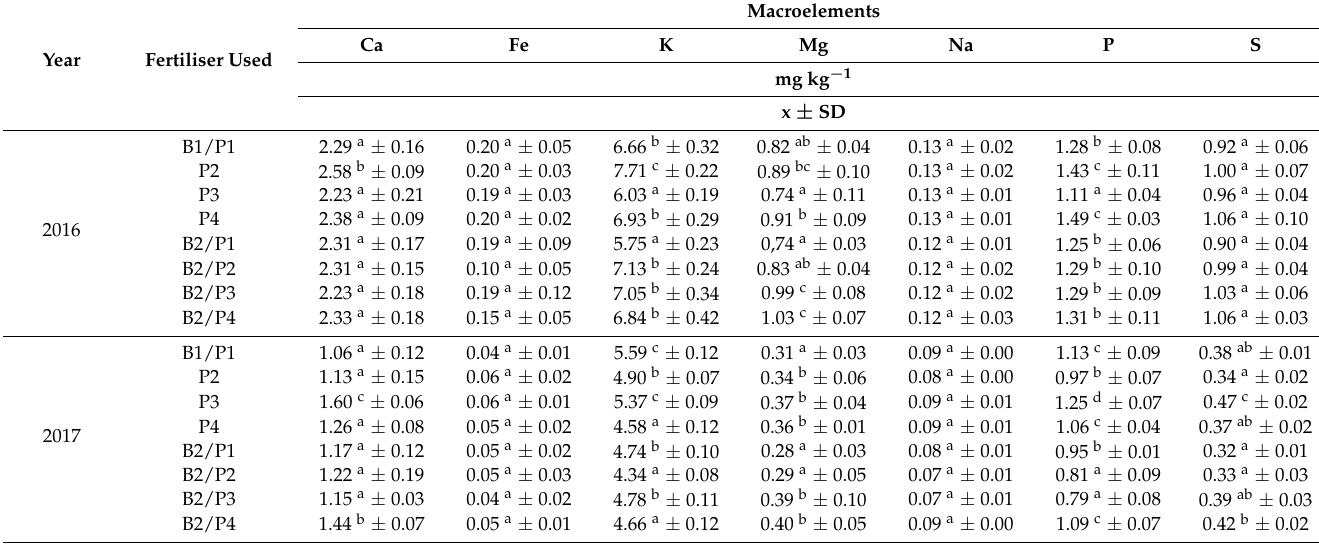
Table 5. Contents of selected macroelements in the biomass of giant miscanthus after the first (2016) and second (2017) year of cultivation, depending on the fertiliser